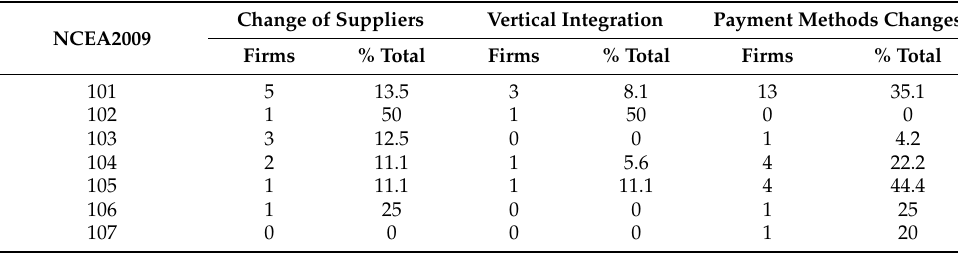
Table 11. Changes made according to consumer